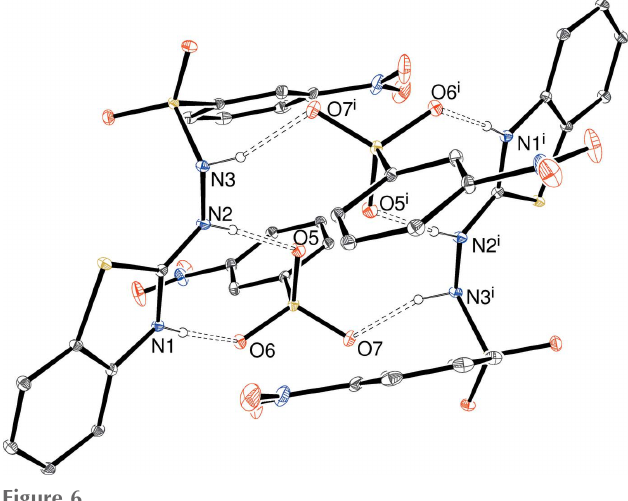
Figure 6 An inversion-generated tetramer in the crystal of (III). Symmetry code: (i) 1 (cid:3) x , 1 (cid:3) y , (cid:3) z .